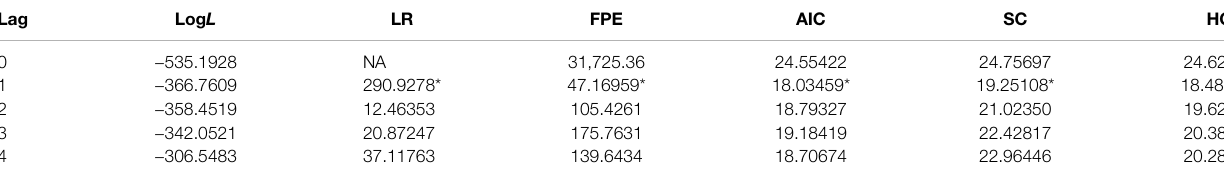
TABLE 3 | Optimal lag length selection based on the Akaike information criterion (AIC) for the cointegration test.